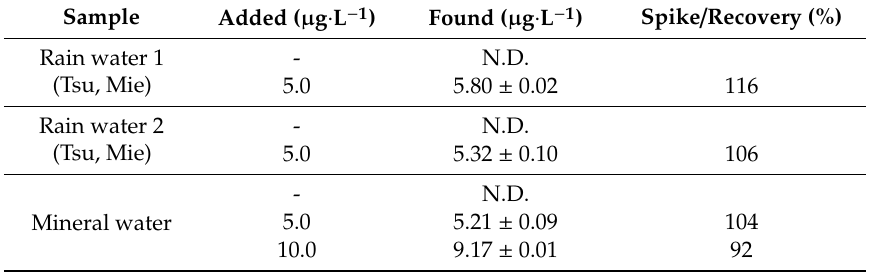
Table 2. Determination of cadmium ions in different real samples using the proposed method ( n = 3). Table 3. Determination of cadmium ions in di ff erent real samples using the proposed method ( n = 3).